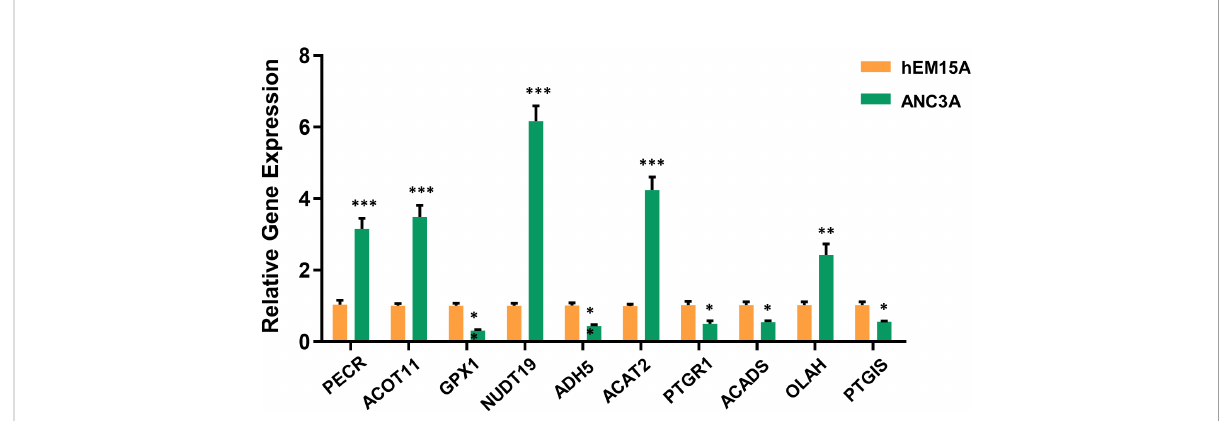
FIGURE 8 Validation of 10-FAMGs expression levels between UCEC cells and controls. ∗ P <0.05, ∗∗ P <0.01, and ∗∗∗ P <0.001. FAMGs: fatty acid metabolism- related genes. UCEC: Uterine corpus endometrial